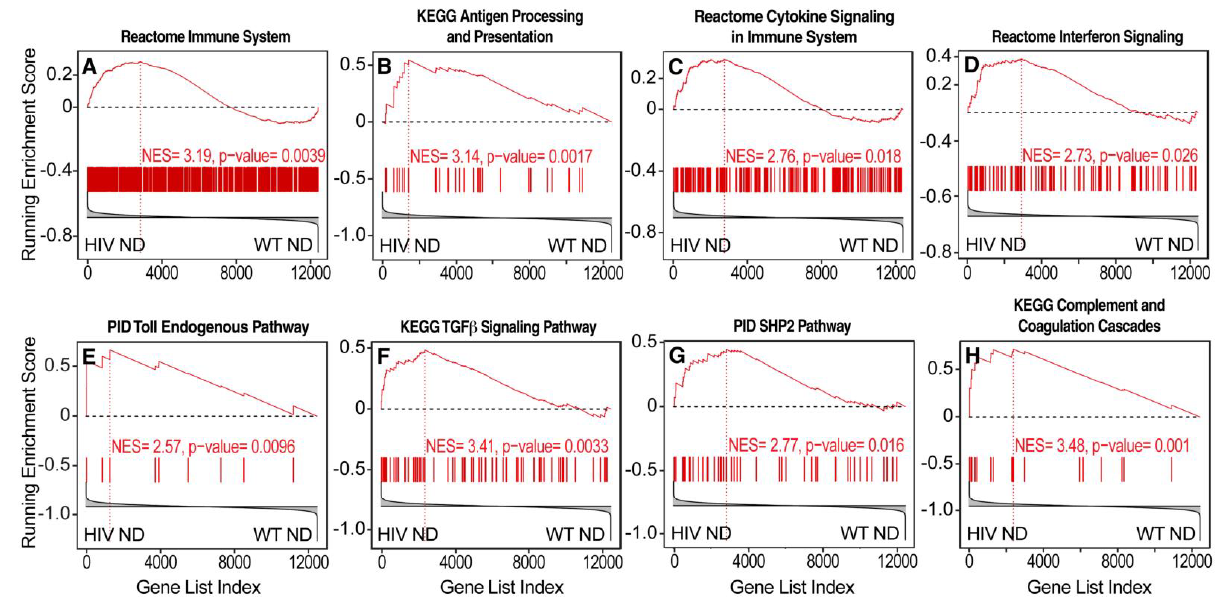
Figure 4. Transcriptional evidence of an increase in neuroinflammation in HIV Tg rats that self- administered oxycodone under nondependent (short access (ShA)) conditions. Pathway analysis by GSEA provided evidence of ( A , B ) broad immune activation and ( C ) the induction of cytokine signaling, including ( D ) interferon (IFN) signaling, ( E ) Toll signaling, ( F ) TGF β , ( G ) SHP2 signaling, and ( H ) complement and coagulation cascades. Each bar represents a gene in the gene set [60]. HIV ND, HIV Tg rats that self-administered oxycodone under nondependent (ShA) conditions; WT ND, wildtype rats that self-administered oxycodone under nondependent conditions. NES = normalized enrichment score [60].